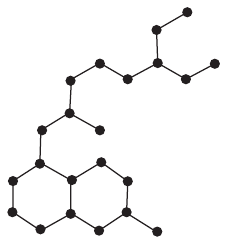
Figure 8: Molecular graph of chloroquine.